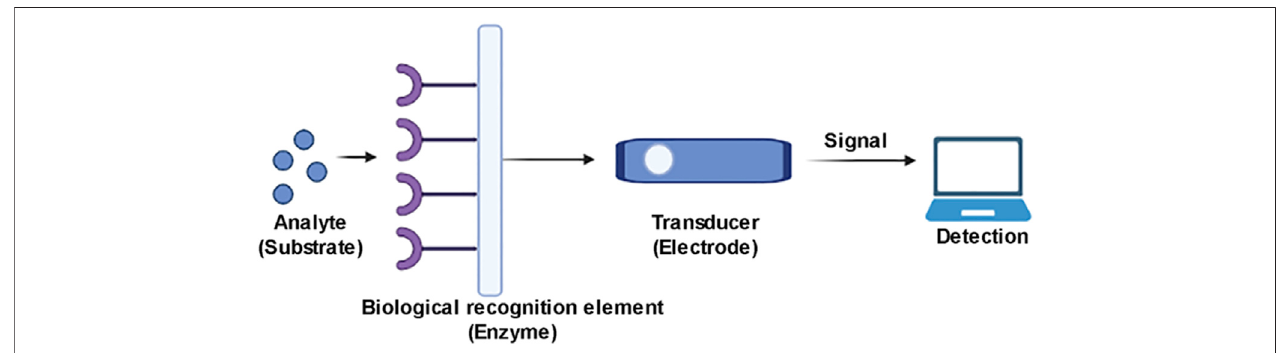
FIGURE 2 | Electrochemical nanobiosensor for viral